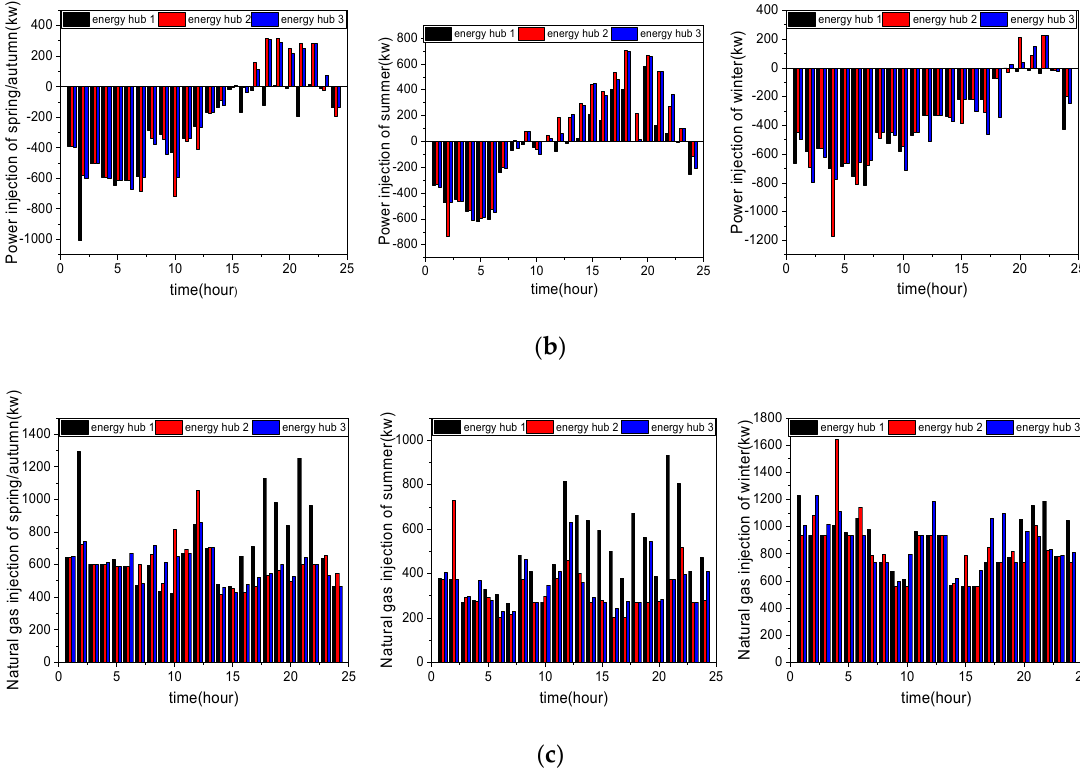
Figure 10. 24-h variations of scheduling factors, power injection, and natural gas injection for three energy hubs in different seasons: ( a ) scheduling factor (spring and autumn, summer, winter); ( b ) power injection (spring and autumn, summer, winter); ( c ) natural gas injection (spring and autumn, summer, winter).